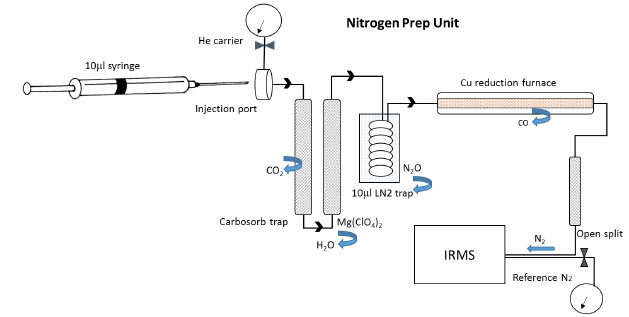
Figure 1. Schematic of the 15 N–N 2 analysis